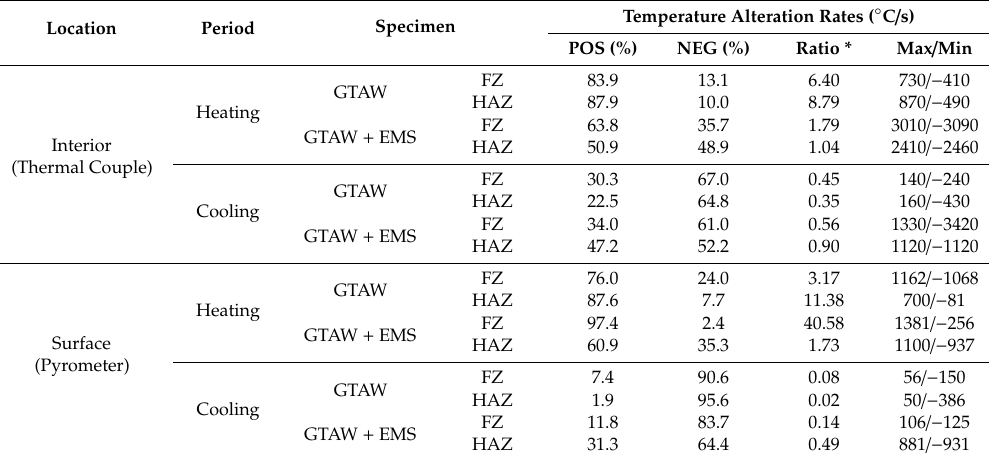
Table 4. The statistics of temperate alteration